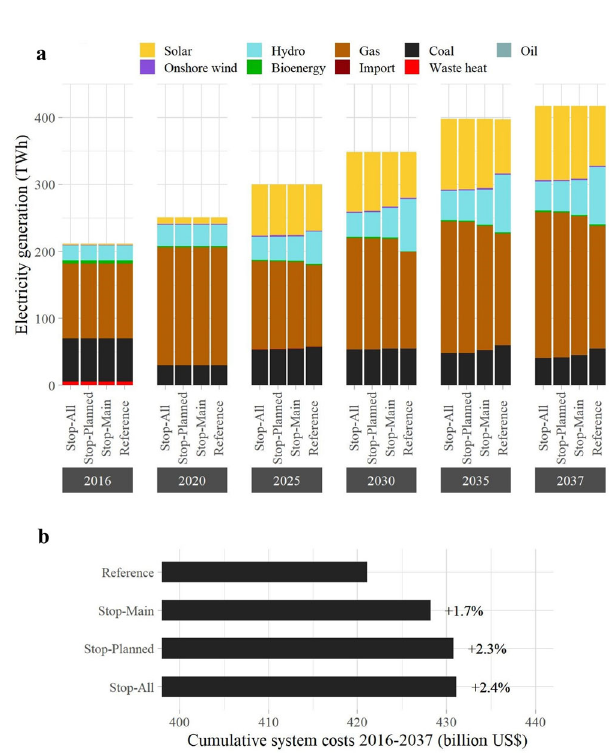
Fig. 4 Future generation mixes and costs. a Evolution of the power mix (aggregated across Thailand, Laos, and Cambodia) for the dam development portfolios outlined in Table 1. In b , we report the corresponding total system